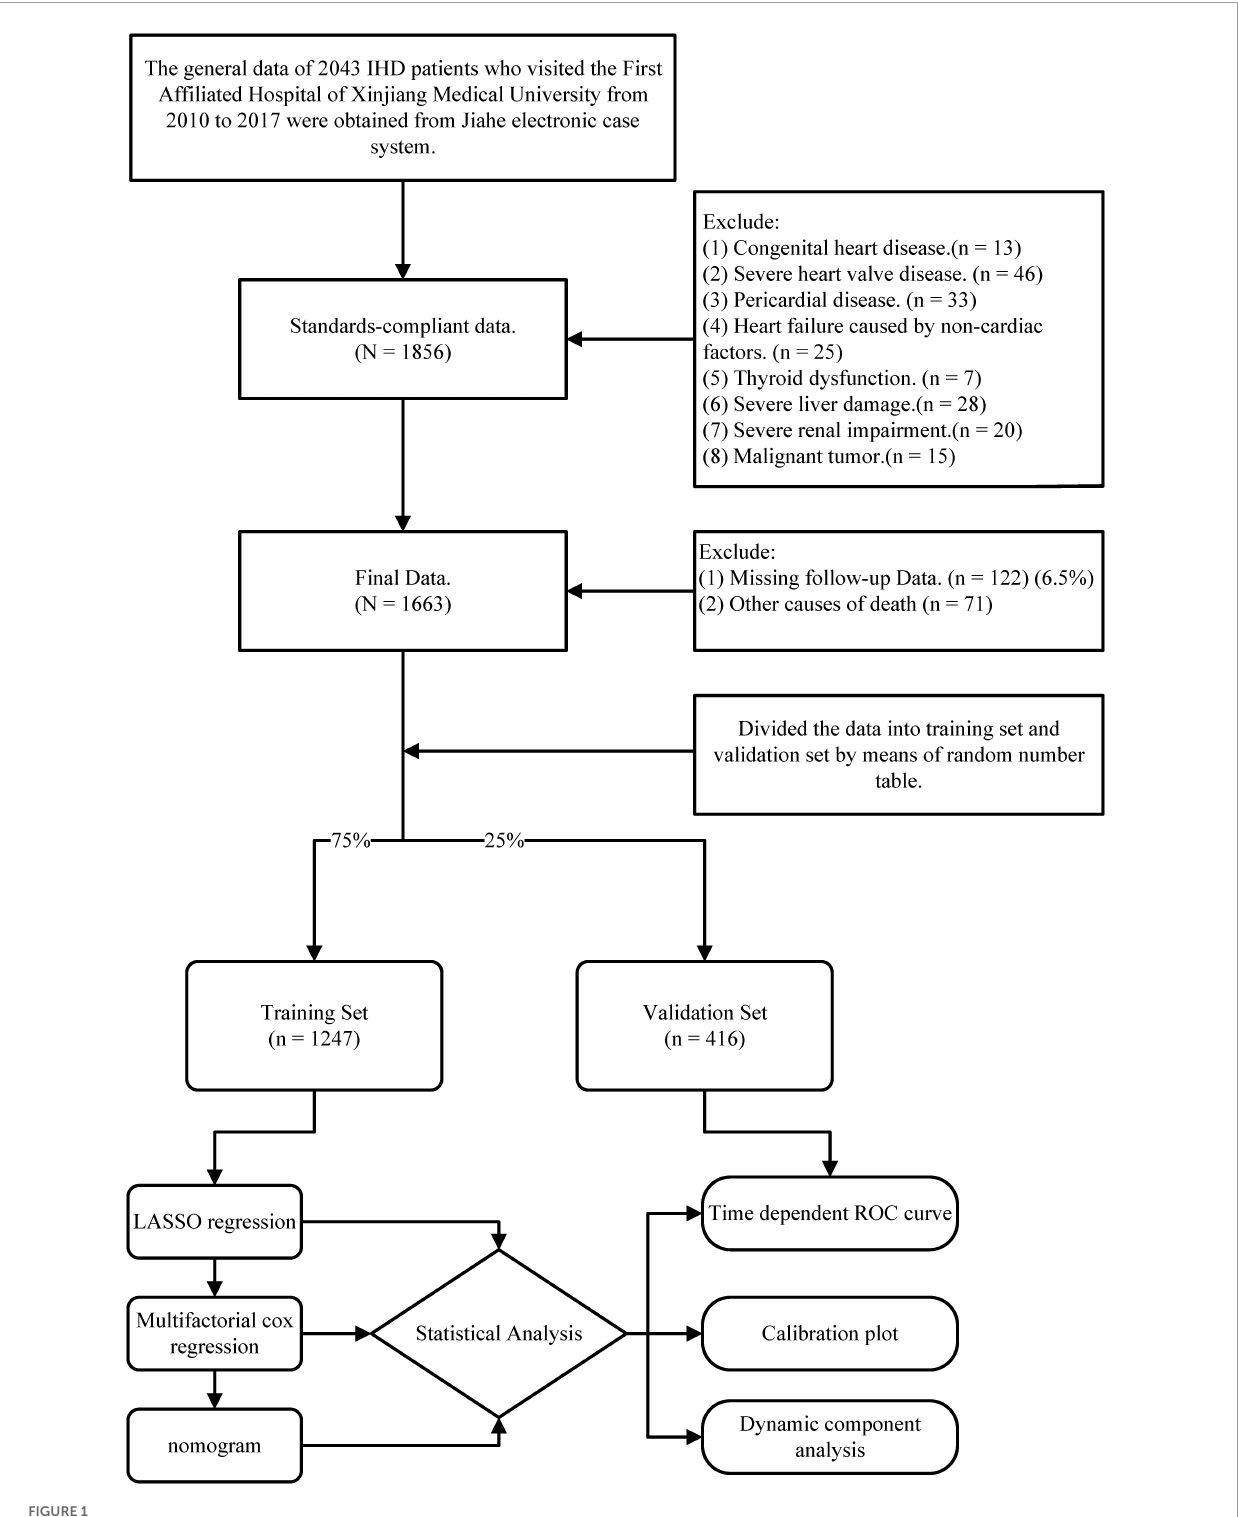
FIGURE1 The flow chart presents the entire process of patient follow-up, data collection, and statistical analysis in this study.